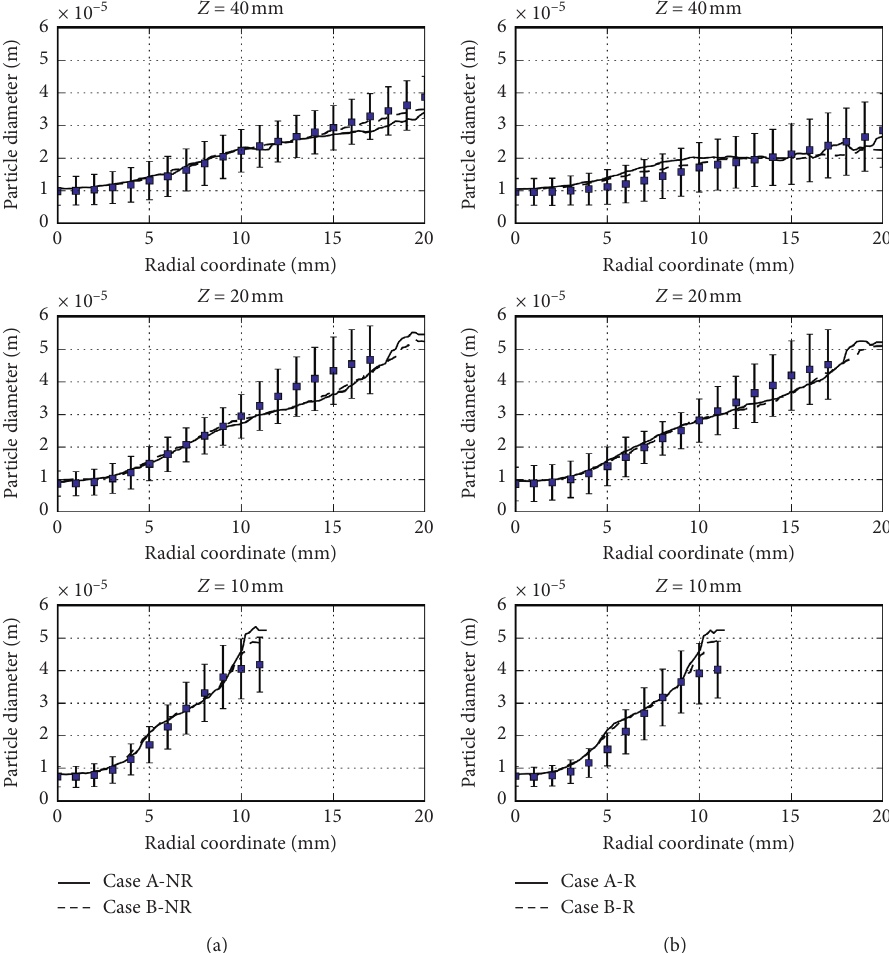
Figure 21: Radial profiles of droplet diameter for nonreacting (a) and reacting case (b). Symbols: experiments, solid line: case A dashed line: case B.